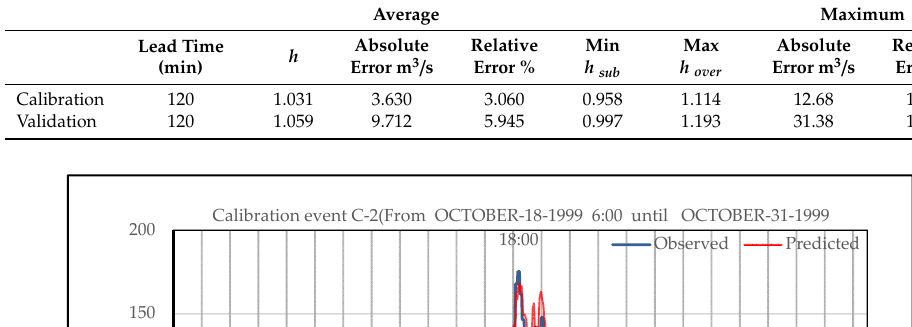
Table 7. Error statistics estimated over a selected family of peak flows in both samples.